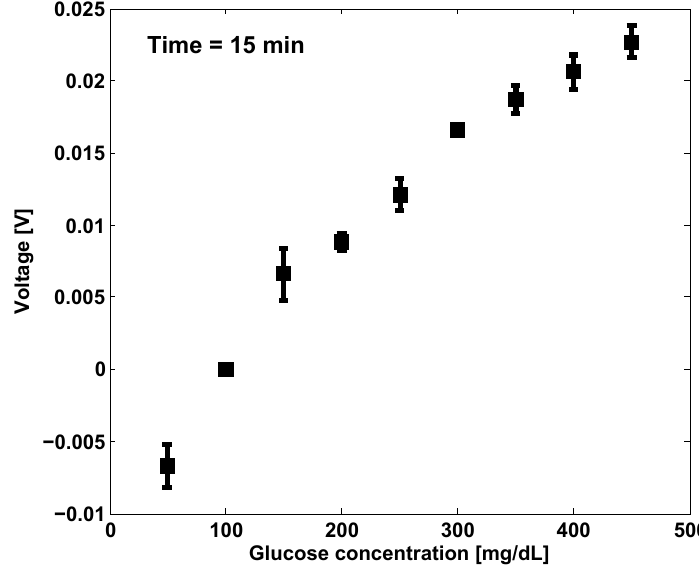
Figure 9. The output voltages obtained after 15 min of osmosis for different glucose concentrations. The error bars indicate the variation observed during three consecutive